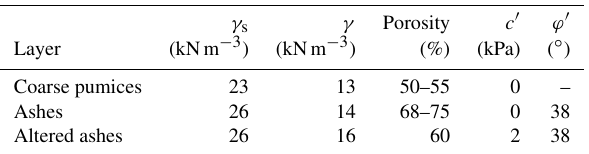
Figure 5. Local stratigraphy of the monitored deposit and posi- tion of the “Jet-fill” tensiometers (L2-1 and L2-2) and of the TDR sensors (S2-1, S2-2). The ceramic tips of the tensiometers, L2-1 ( z = 0.60m) and L2-2 ( z = 1.00), are respectively installed at the same depth, z , of the centres of the TDR probes, S2-1 and